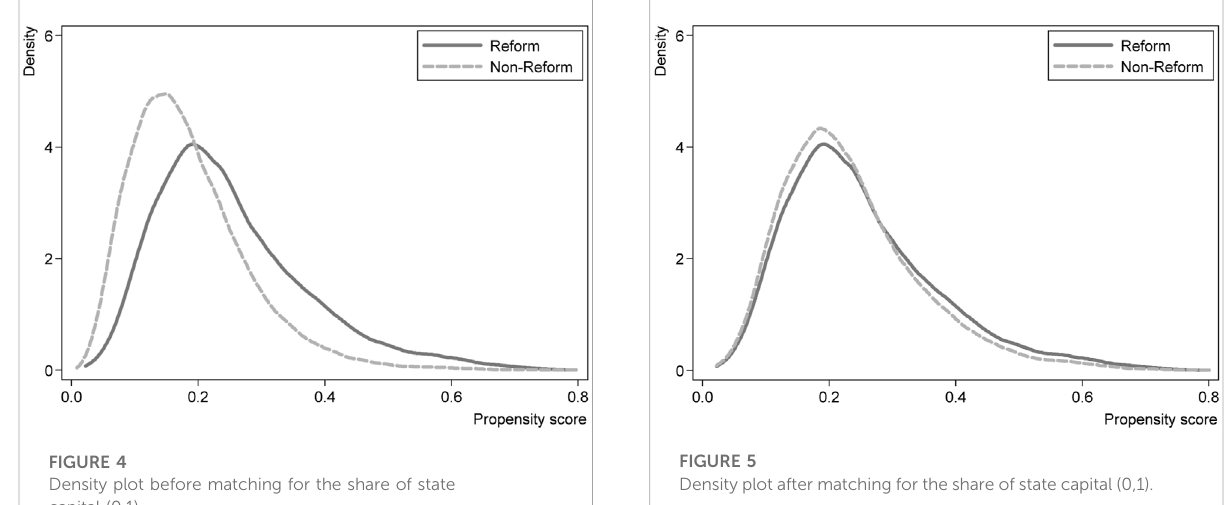
FIGURE 5 Density plot after matching for the share of state capital